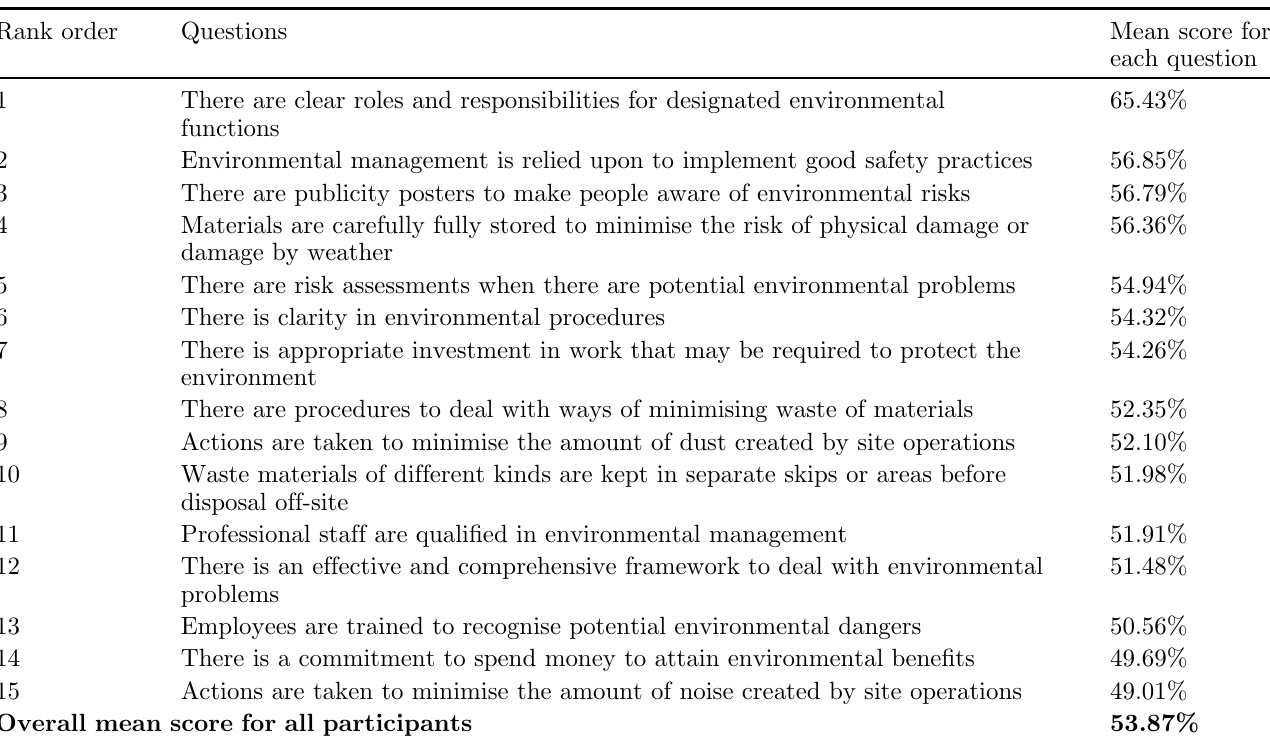
Table 1. 15 statements to which respondents indicated the extent to which they agreed or disagreed: there is commitment to environmental management (Variable of